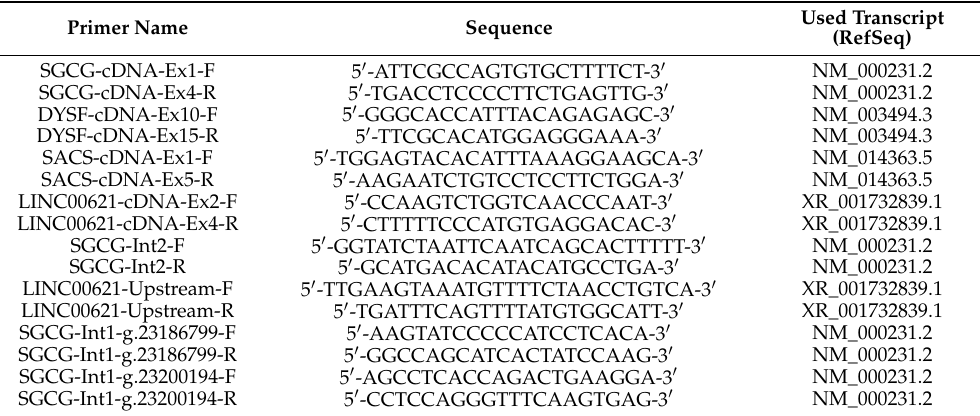
Table 1. Primers used for PCR and Sanger